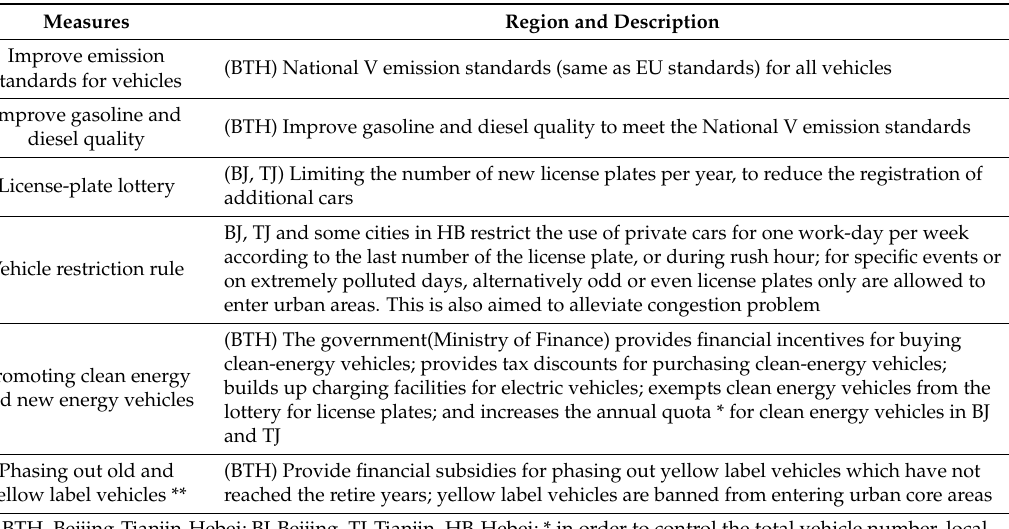
Table A4. Major traffic related emission control measures in BTH # .